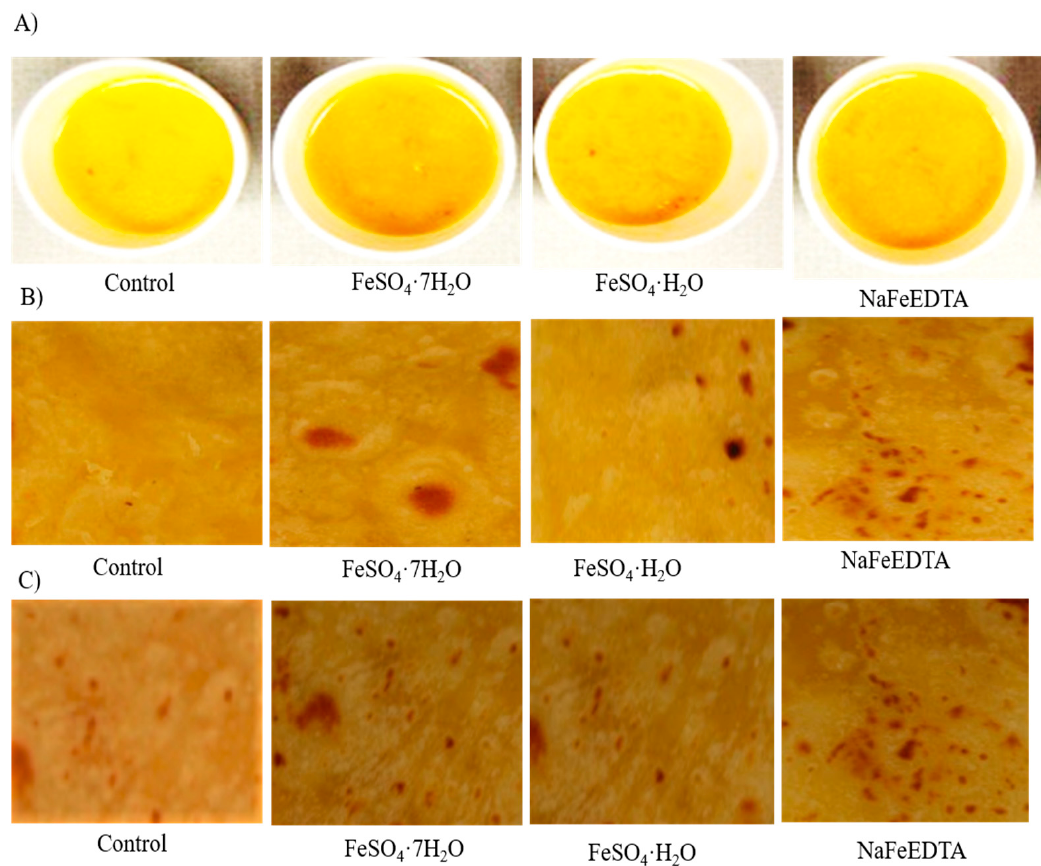
Figure 3. Images of the chickpea products used for sensory evaluation. Images of unfortified (control) and Fe-fortified ( A ) soup prepared from split desi seed, ( B ) chapattis prepared from desi flour and ( C ) chapattis prepared from kabuli flour with 2000 µg g − 1 of Fe fortificant solution prepared from three different Fe salts: FeSO 4 ·7H 2 O, FeSO 4 ·H 2 O and NaFeEDTA.